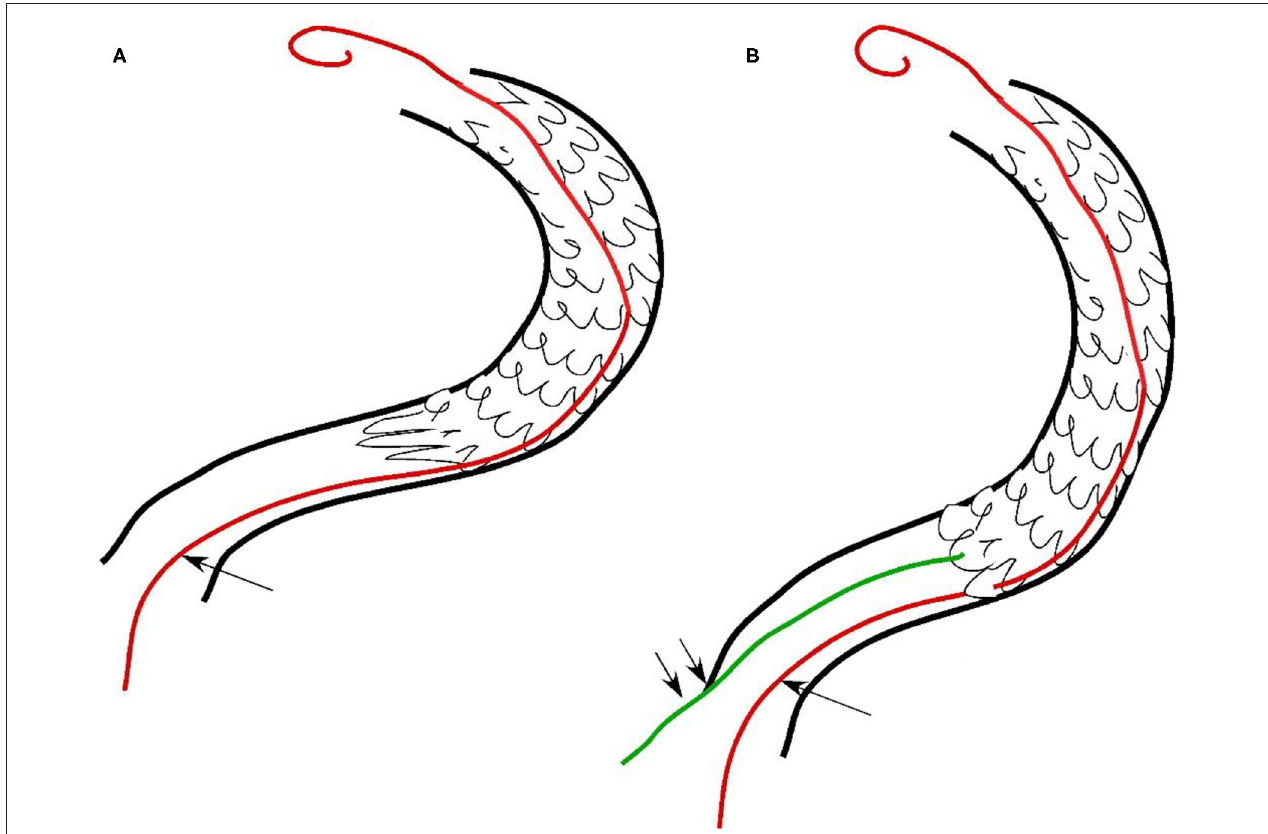
FIGURE 3 | Hand sketch to show the deployment of two micro-guidewires. (A) The first micro-guidewire (longer arrow) was sent through the lateral stent mesh into the stent lumen after collapse of the stent proximal end. (B) After the artery was straightened by the first micro-guidewire with the stent proximal end being opened, the second micro-guidewire (double short arrows) was sent right through the opened proximal end for deployment of a supporting